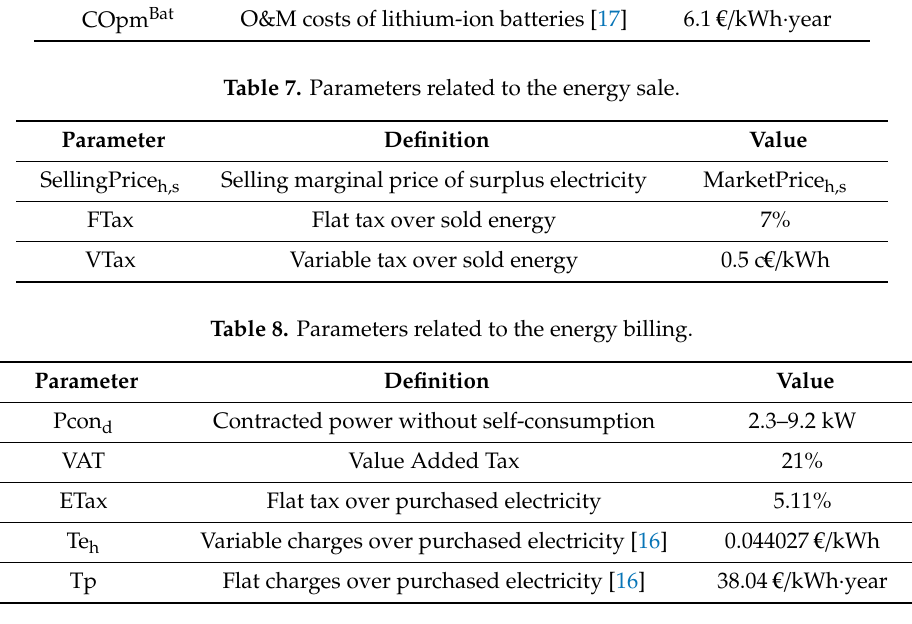
Table9. Parametersrelatedtothesourcesofuncertaintyorstochasticparametersoftheeconomicconstraints.